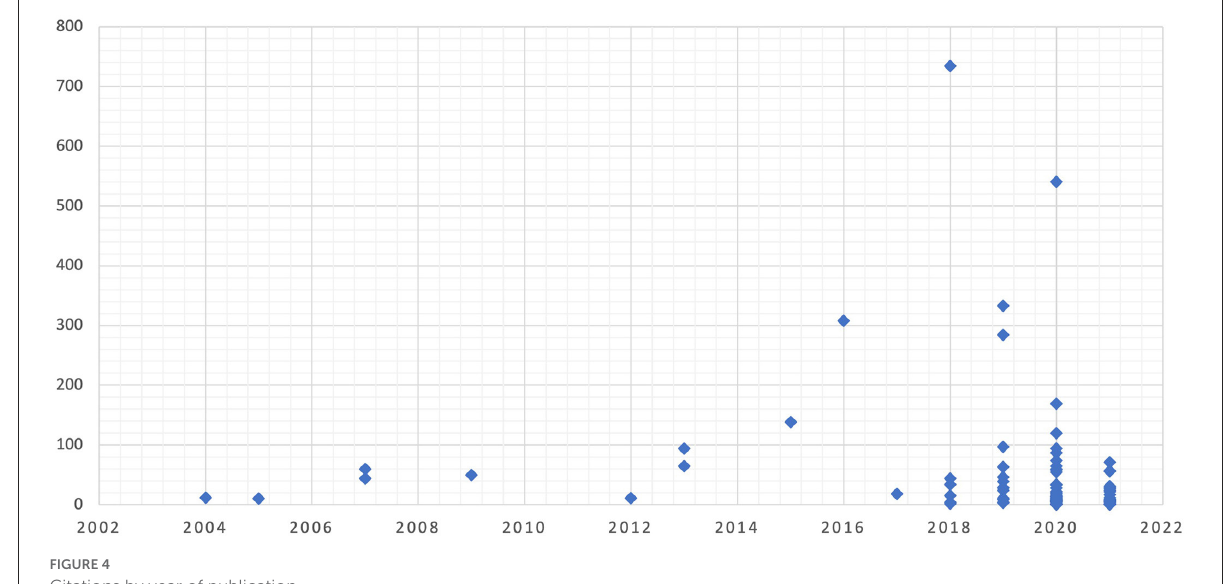
FIGURE4 Citations by year of publication.